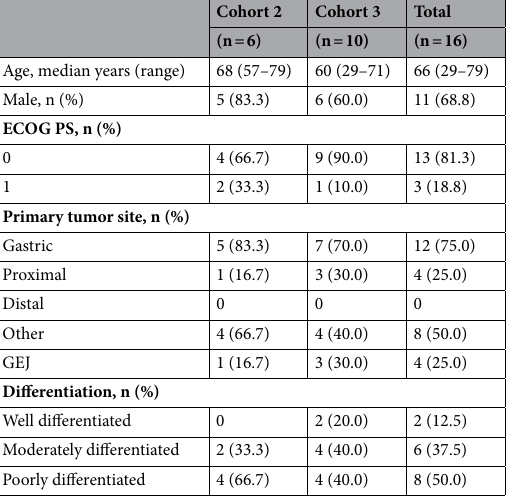
Table 1. Baseline patient characteristics. The safety analysis set includes subjects who received at least one dose of ADX. ECOG PS Eastern Cooperative Oncology Group performance status, GEJ gastroesophageal